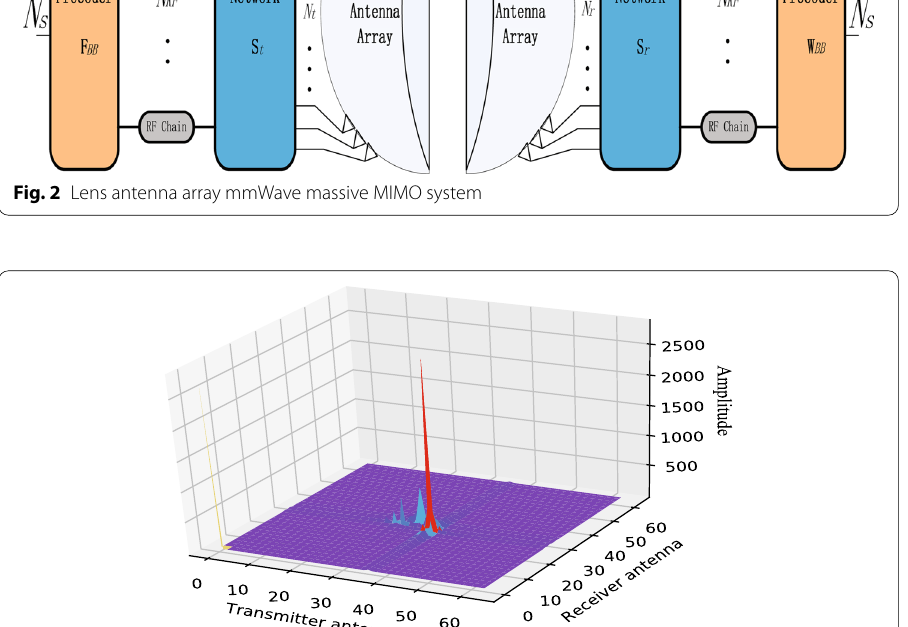
Fig. 3 Amplitude of mmWave channel in beam